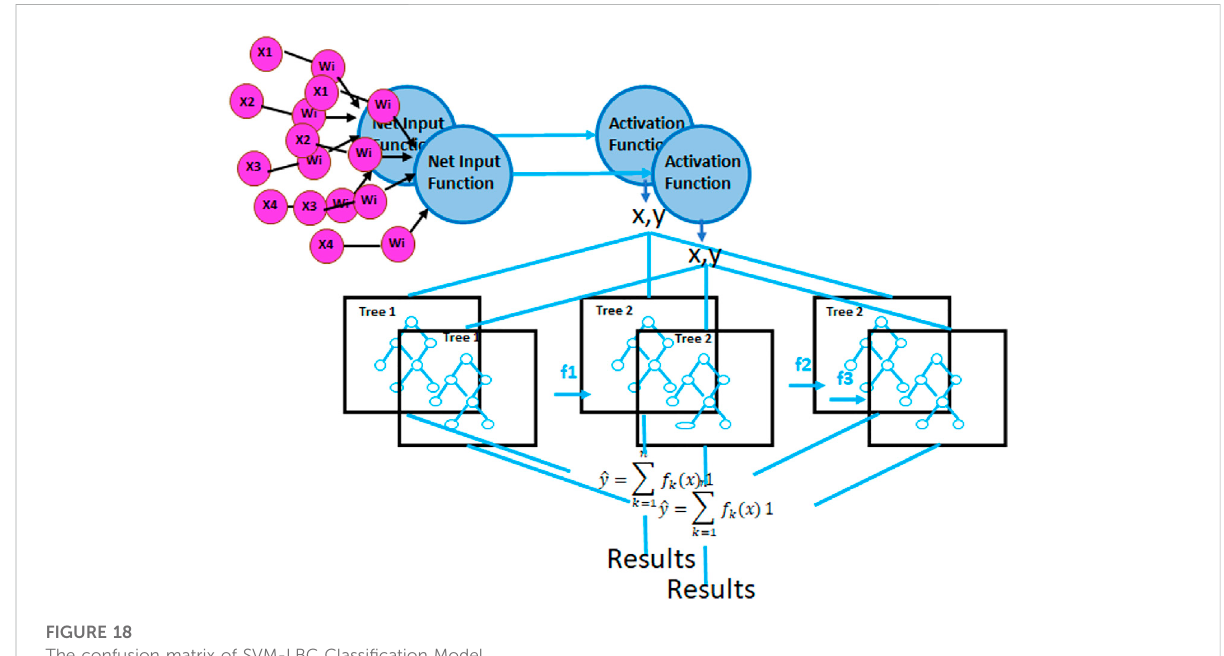
FIGURE 18 The confusion matrix of SVM-LBC Classi fi cation Model.